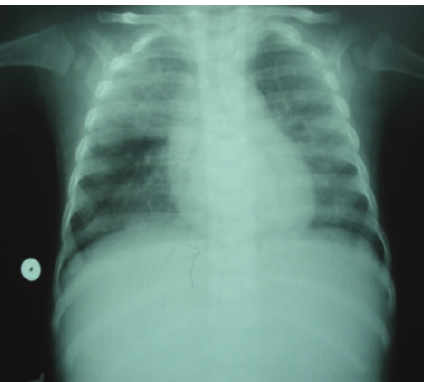
Figure 1: Chest X-ray: bilateral alveolointerstitial infiltrate.